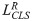
The framework of CheXLocNet.The features were extracted from the origin radiographs by the backbone network. RoI was screened out by RPN. RPN produced two losses LCLSR and LREGR during the training time. The classification network and the mask network produced their losses and predictions, respectively. The softmax was used for outputting the probability for being a lesion area for each RoI. The per-pixel sigmoid was used for outputting a mask. RoI, rectangular region of interest; RPN, region proposal network.